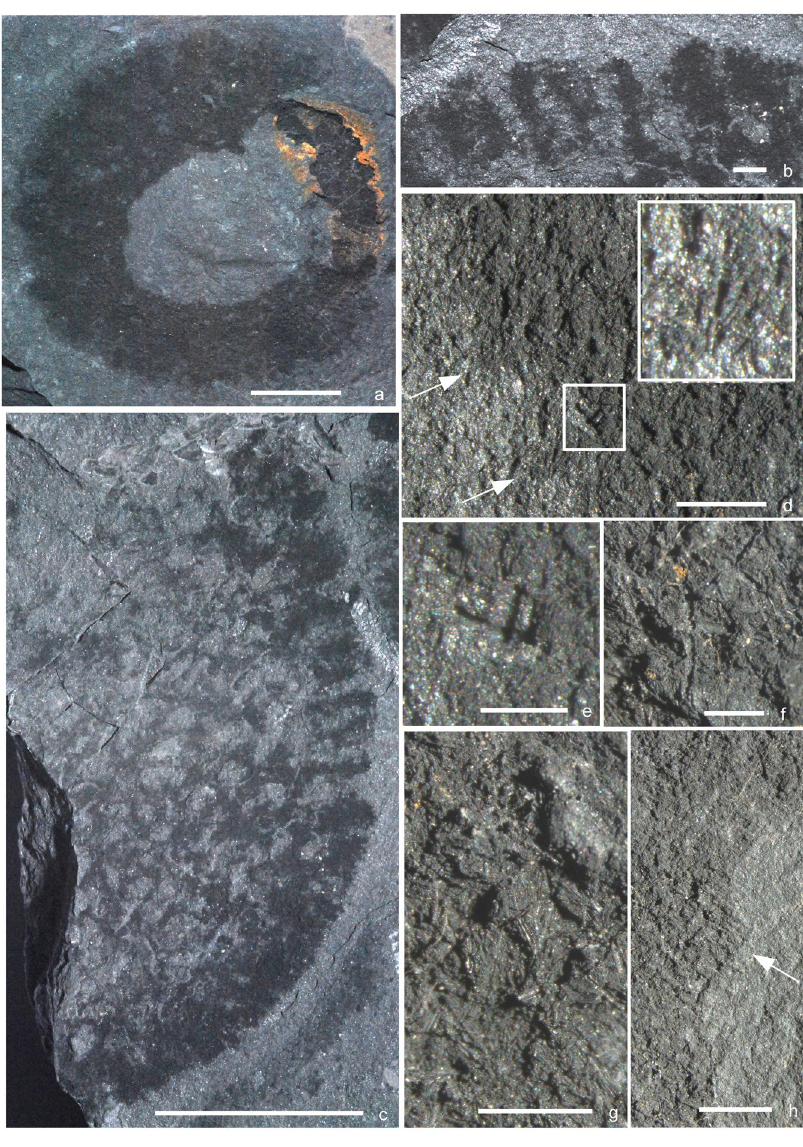
Figure 2. Conciliospongia anjiensis gen. et sp. nov. ( a , f–h ) Paratype (specimen number NIGP 165187): ( a ) Overall view of dorso-ventrally flattened specimen with osculum central; ( f ) detail from near oscular margin, including two large hexactines amongst fine monaxons; ( g ) detail of central upper part of body wall, showing tufts of fine parallel monaxons; ( h ) oscular margin showing cuspate margin (arrow) with localized projecting spicules, and tufted texture of wall, composed of small overlapping clusters of parallel monaxons (adjacent to arrowed cusp). ( b–e ) Holotype (specimen number NIGP 165186): ( b ) Detail of upper right margin, rotated anticlockwise with respect to ( c ), showing walls composed of spicule tufts and occasional spicules crossing spaces of reticulation; ( c ) overall view of partial, laterally-compressed specimen with well preserved reticulate skeletal wall; ( d ) detail of the lower right region of ( c ) on the counterpart, showing lateral projecting spicule tufts (arrowed, with lower arrowed region magnified and inset), position of ( e ) (box), and finely-tufted skeleton; ( e ) detail of ( d ), showing hexactine embedded in body wall. Scale bars: ( a , c ) 10 mm; ( b , d , h ) 1 mm; ( e – g ) 0.5